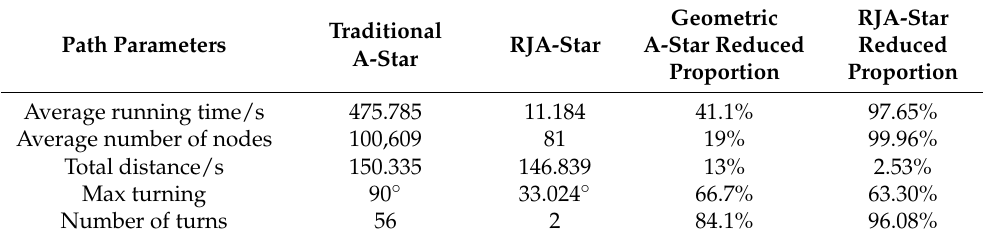
Table 4. Comparison of indexes of three